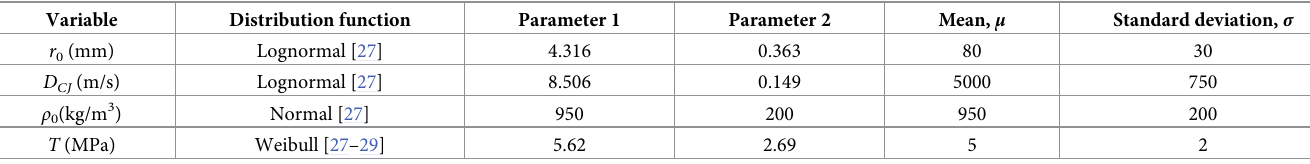
Table 1. Means and standard deviations of random